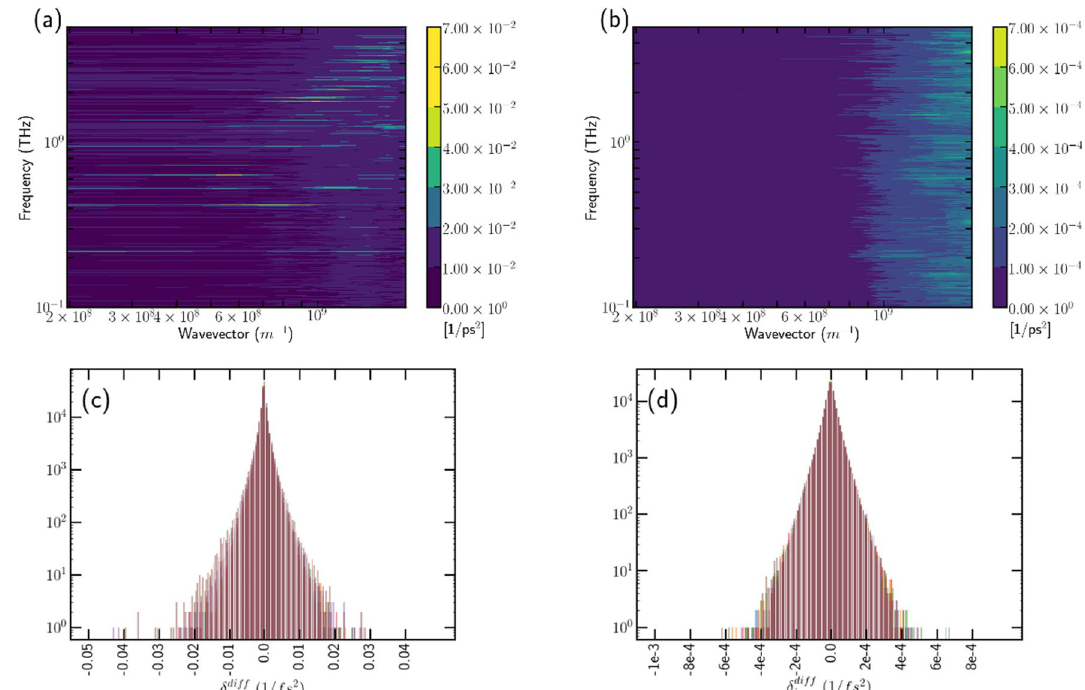
Figure 3. Contour of the value of δ diff along the tube axis. Each value is distributed with dt=10 fs along the x axis. ( a ) MD simulation result, ( b ) CGMD simulation results, ( c ) histogram of the diffused level in simple bead system from MD simulation result during 10 ns, with the results from all UAs shown, ( d ) histogram for the CGMD simulation